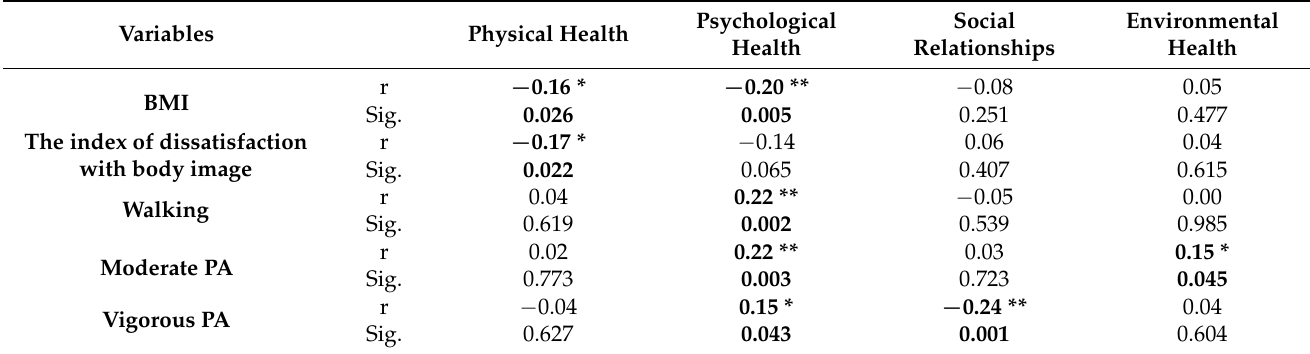
Table 2. Relationships of BMI, body image, and quality of